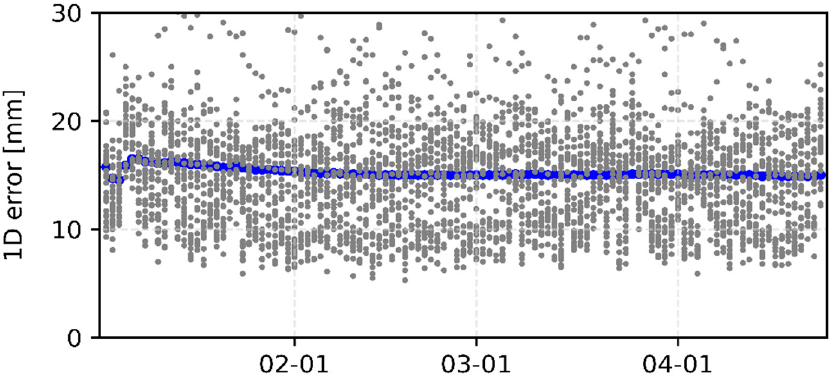
Figure 7. Consistency between iGMAS and IGS final combined GPS orbits. The gray circles indicate each GPS satellite for individual days and the blue circles represent the median RMS of all satellites.